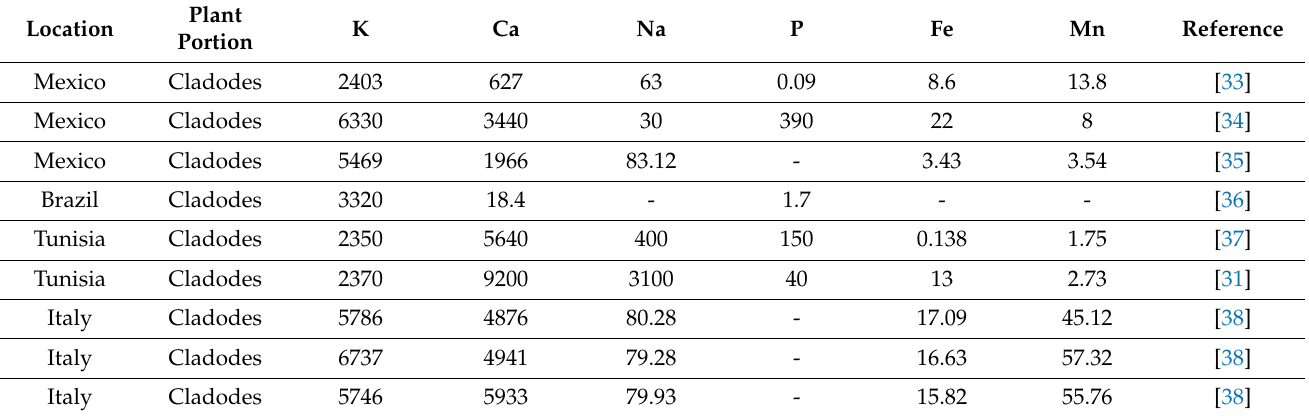
Table 2. Mineral content (mg/100 g) of O. ficus-indica according to different